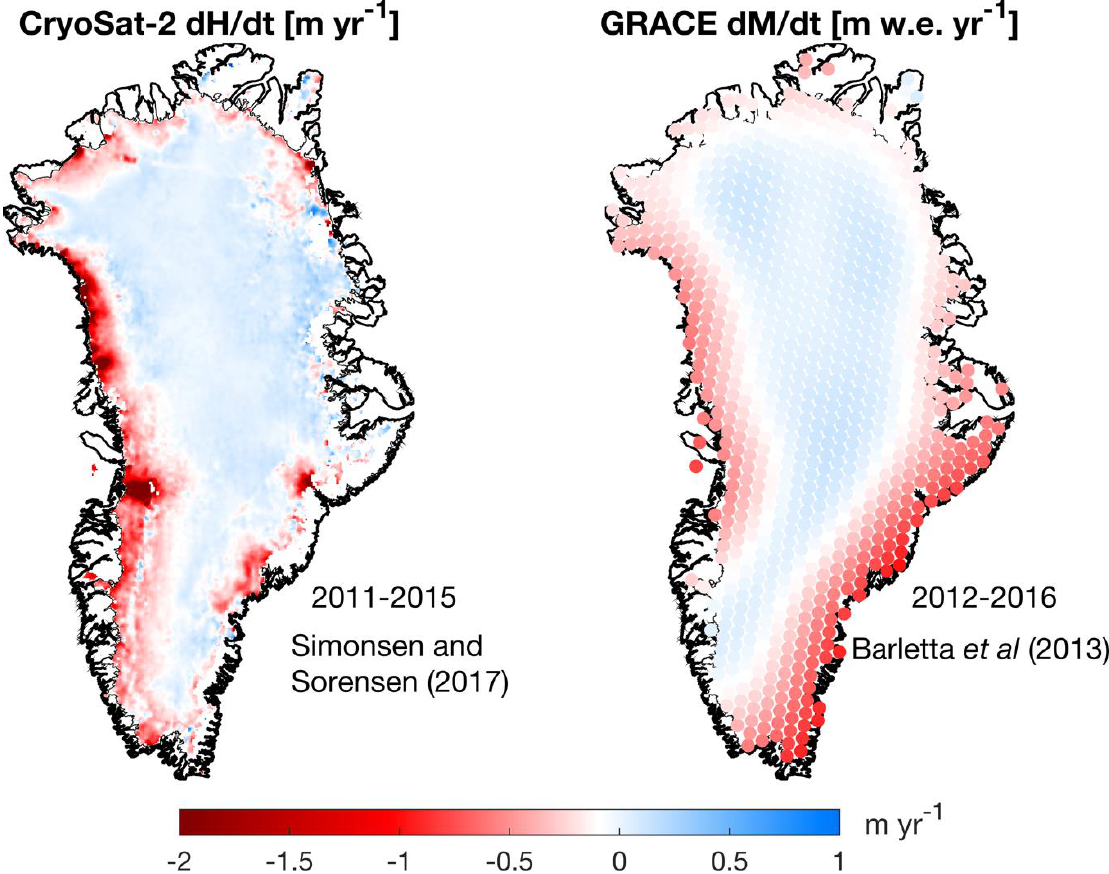
Figure 7. Comparison of ice surface elevation change dH / dt [m yr − 1 ] from CryoSat-2 radar altimetry with mass change dM / dt [(m w.e. yr − 1 ) from GRACE. Both missions observe similar spatial patterns, with mass losses concentrated in the southeast and western sectors, and a slight thickening of the interior. Altimetry resolves rapid thinning concentrated in narrow outlet glaciers along the coastal margins. The CryoSat-2 Surface Elevation Change (SEC) product version 2.2 is based on the ESA Baseline C CryoSat-2 product and is provided at 1 km grid spacing as a five-year average for the period 2011 – 2015 [234]. The GRACE mass balance product is produced by the Danish Institute of Space (DTU Space) and is provided as a five-year average for the period 2012 – 2016 with a 500 km nominal spatial resolution [235]. Both datasets are Essential Climate Variables provided by the ESA